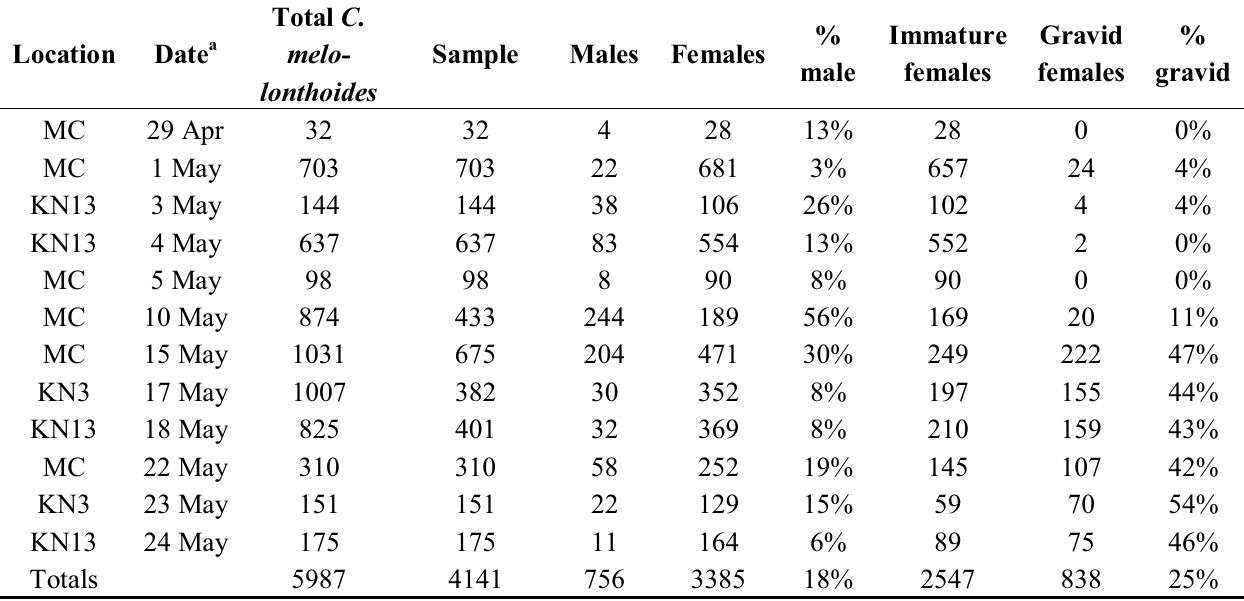
Table 6. Reproductive status of adult Cochliotis melolonthoides attracted to light-trap, April (cid:177) May 1987.